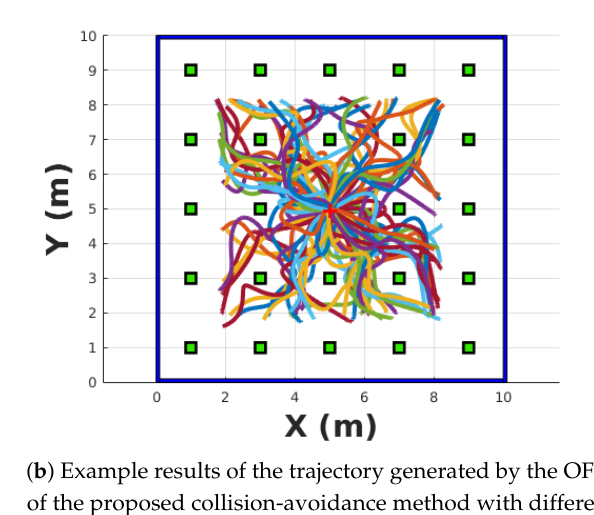
( a ) Gazebo environment used for the simula- tion experiments. The goal can randomly gen- erate in the area between these two red squares. Figure 6. Simulation experiments and example results of the OFM when applied in the case of different initial yaws.